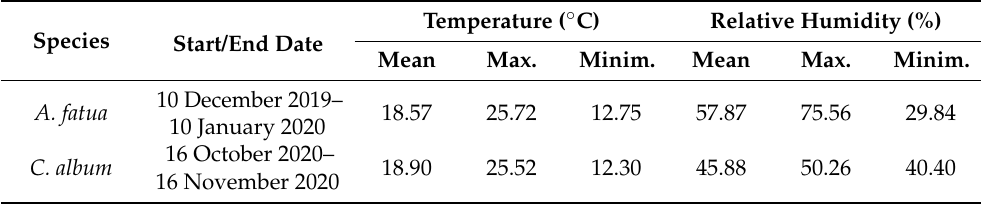
Table 1. Greenhouse conditions during the herbicidal tests.